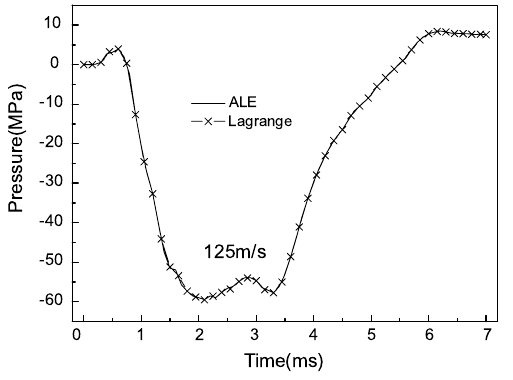
Fig. 21. Time history of pressure at the center on inner surface of windshield for different analytic methods.